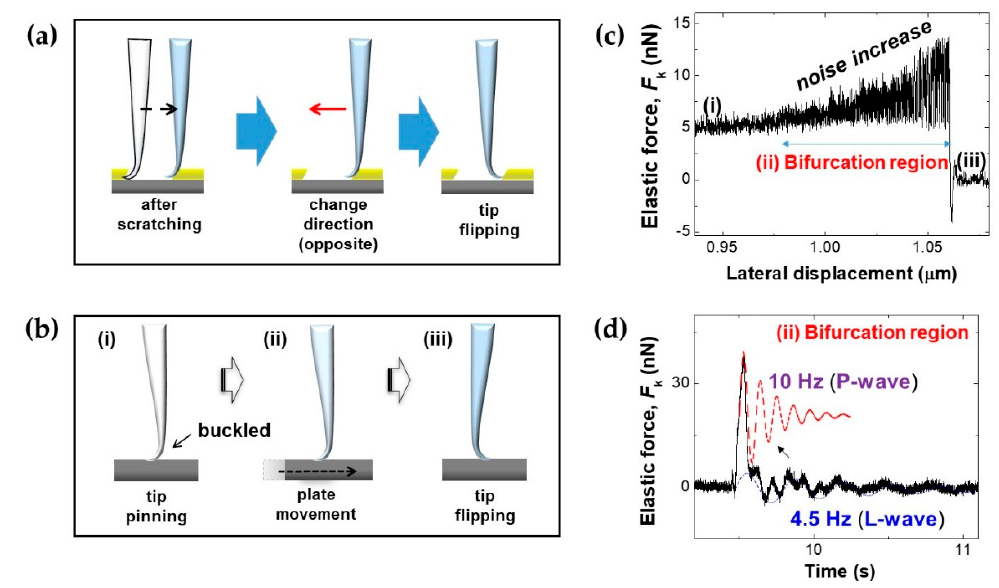
Figure 8. Buckled tip-based mechanical sensor. ( a ) Reversing the buckled tip in the opposite direction for additional nanoscratching. ( b ) Experimental procedure: (i) approaching and buckling the nanorod tip, (ii) plate movement in the lateral direction, (iii) abrupt flipping of the buckled tip. ( c ) Noise increase with increase of sensitivity in the region of bifurcation (data from [22]. ( d ) Sensing of mechanical perturbations transferred from the impact on the optical table (data from [22]).